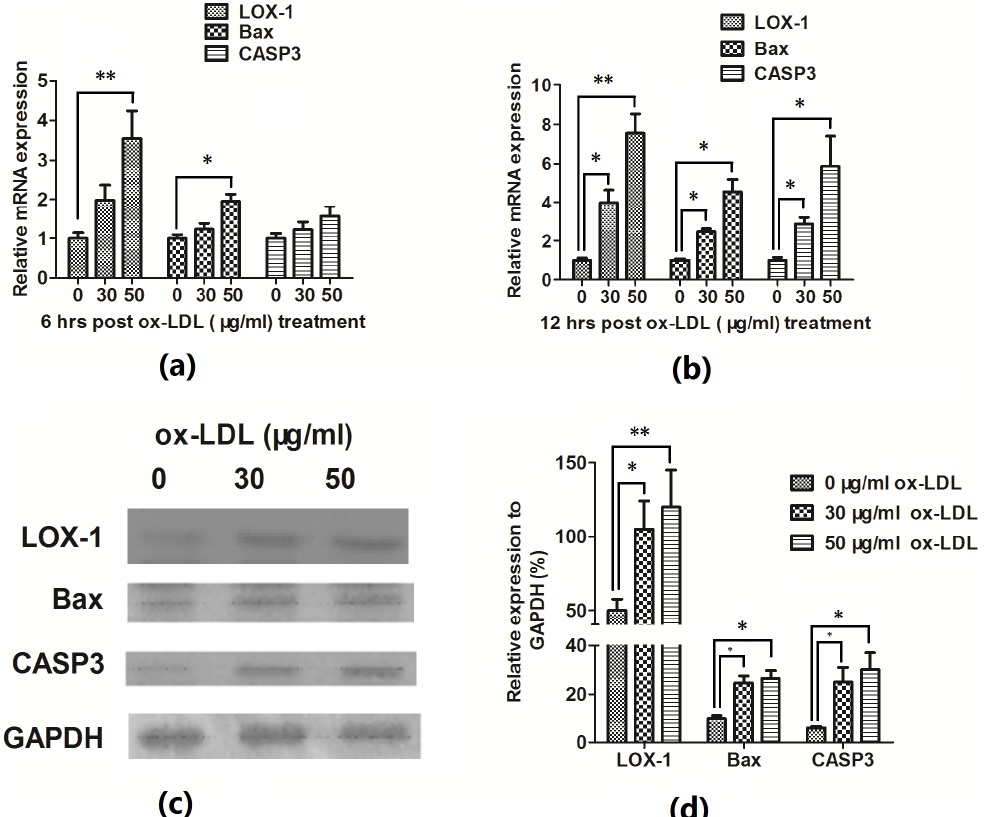
Figure 2. Ox-LDL upregulated LOX-1 and apoptosis-associated molecules. ( a ) The mRNA expressions of LOX-1, Bax in EAhy926 cells were significant upregulated 6 h post ox-LDL treatment. ( b ) The mRNA expressions of LOX-1, Bax and CASP3 in EAhy926 cells were significant upregulated 12 h post ox-LDL treatment. ( c ) and ( d ) The western blot analysis for LOX-1, BAX and CASP 3 of EAhy926 cells post ox-LDL treatment. All results